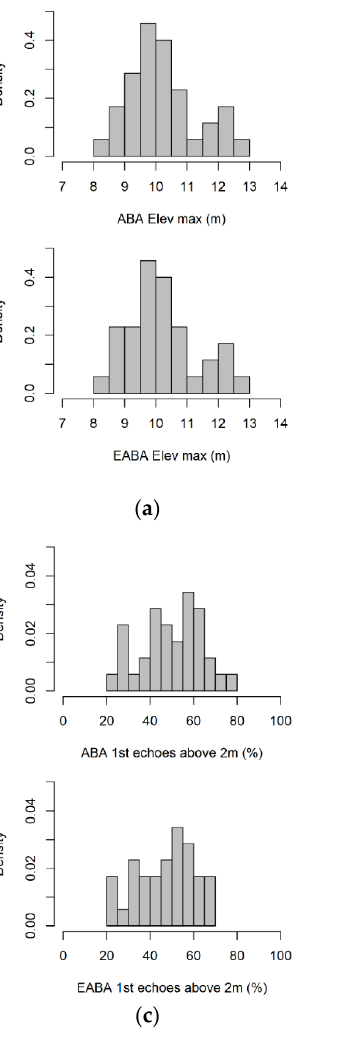
Figure 5. Distribution of ALS-based statistics in the sampling when correcting edge effects (i.e., enhanced area-based approach (EABA)) and when not (i.e., ABA). ( a ) Maximum elevation of ALS echoes in the plots; ( b ) the 50th height percentile; ( c ) proportion of first echoes above 2 m; ( d ) proportion of first echoes above the mean elevation of ALS echoes.